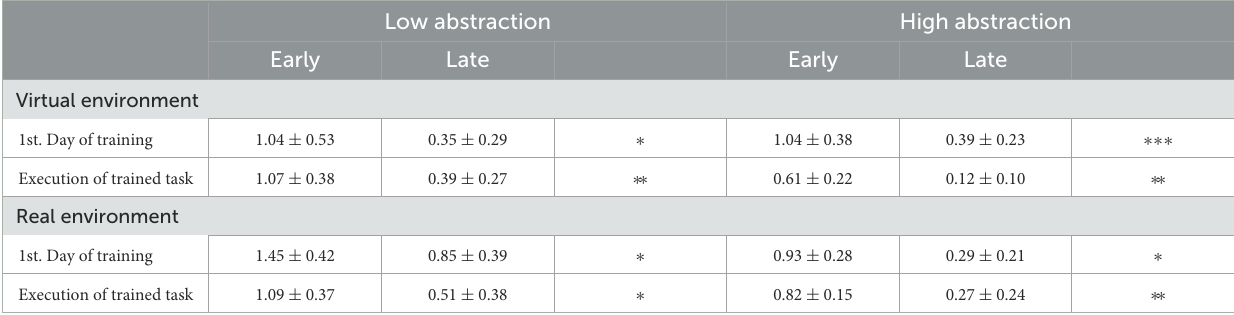
TABLE 2 Entropy of brain activity temporal segments in the cognitive task (a one-tailed Mann–Whitney U analysis was applied). Low abstraction High abstraction Early Late